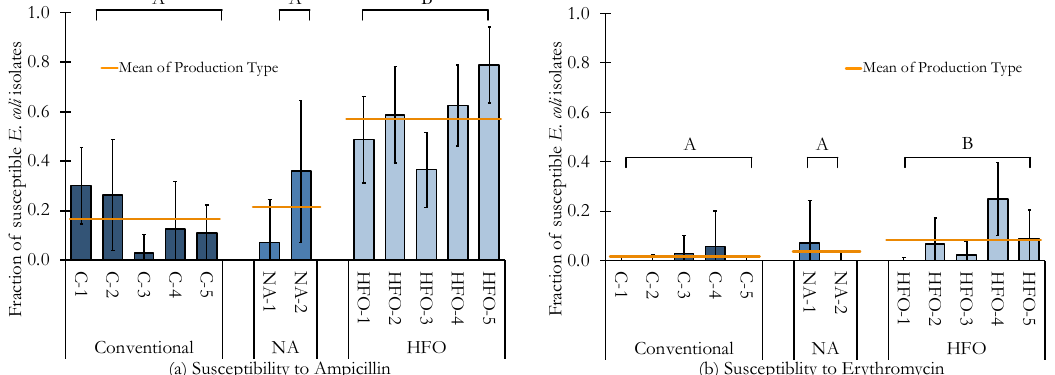
Figure 2. Each column per production grouping represents a unique retail broiler chicken option. Error bars represent 95% confidence intervals of the sampling distribution of the proportion of isolates susceptible. Error bars that would theoretically extend past zero were truncated. Statistical significance letters A and B shown on the graphs refer to whether the fraction of isolates susceptible are different between production groupings. Same letters show no significant difference, while different letters show a difference between groupings. The vertical orange line represents the mean fraction of susceptible E. coli isolates to ( a ) ampicillin and ( b ) erythromycin grouped by Conventional , No Antibiotics (NA) , and Humane Family Owned (HFO) .